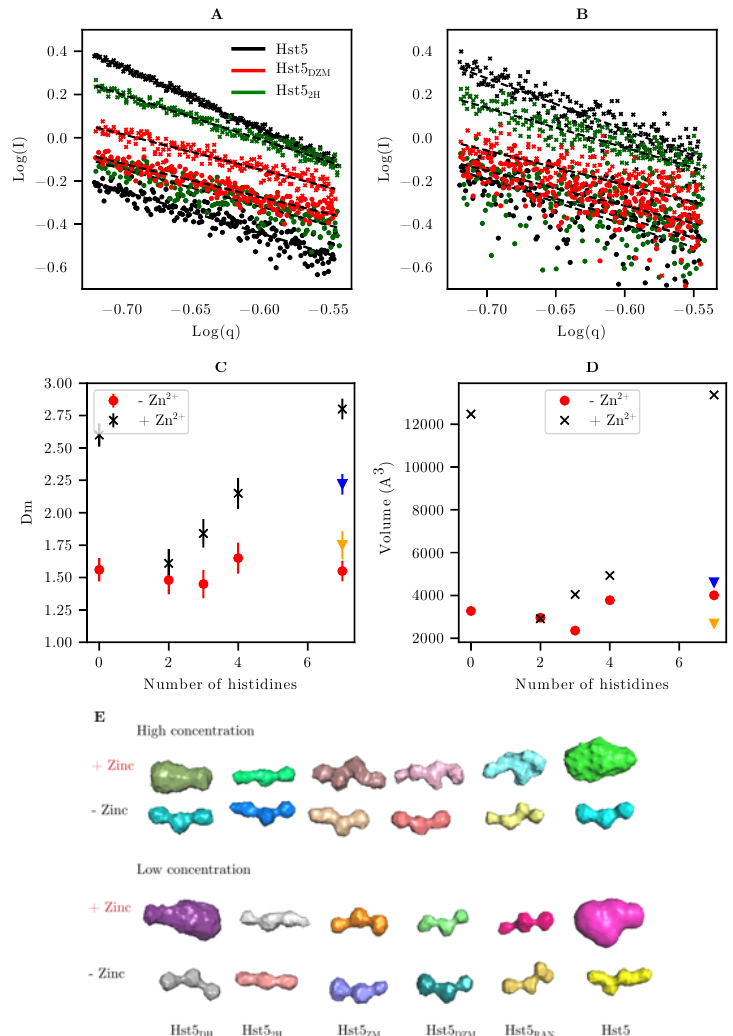
Figure 7. The effect of Zn 2+ on the shape of Hst5 and selected variants ( A ) Log-Log plot of SAXS of 5 mg/mL Hst5 variants in the absence of Zn 2+ (circles) and presence of Zn 2+ (squares). The dashed lines represent a fit of the power law relationship to the scattering data from which the fractal dimension D m was estimated. ( B ) The same plot as A shown for low concentration scattering data (1 mg/mL). ( C ) Plot of D m against the number of histidines present in the Hst5 variants in the absence of Zn 2+ (red circles) and in the presence of Zn 2+ (black crosses). ( D ) The volume of the scattering envelope, in the presence and absence of Zn 2+ . The randomised sequence is shown as triangles where yellow is in the absence of Zn 2+ and blue in the presence. ( E ) Scattering envelopes produced by DAMMIF corresponding to the volumes shown in Figure